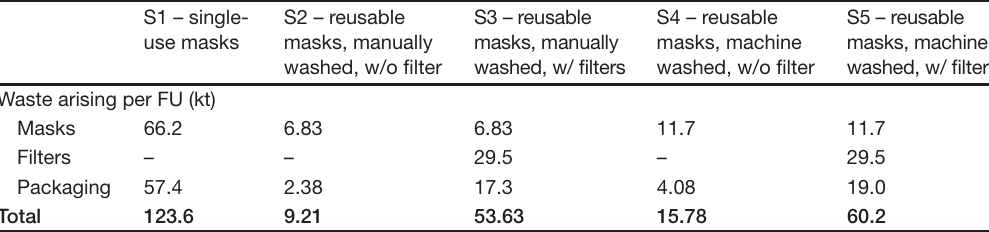
Table 4. Waste arising (thousand tonnes per FU) due to face mask use in the UK for 1 year. S1 – single- use